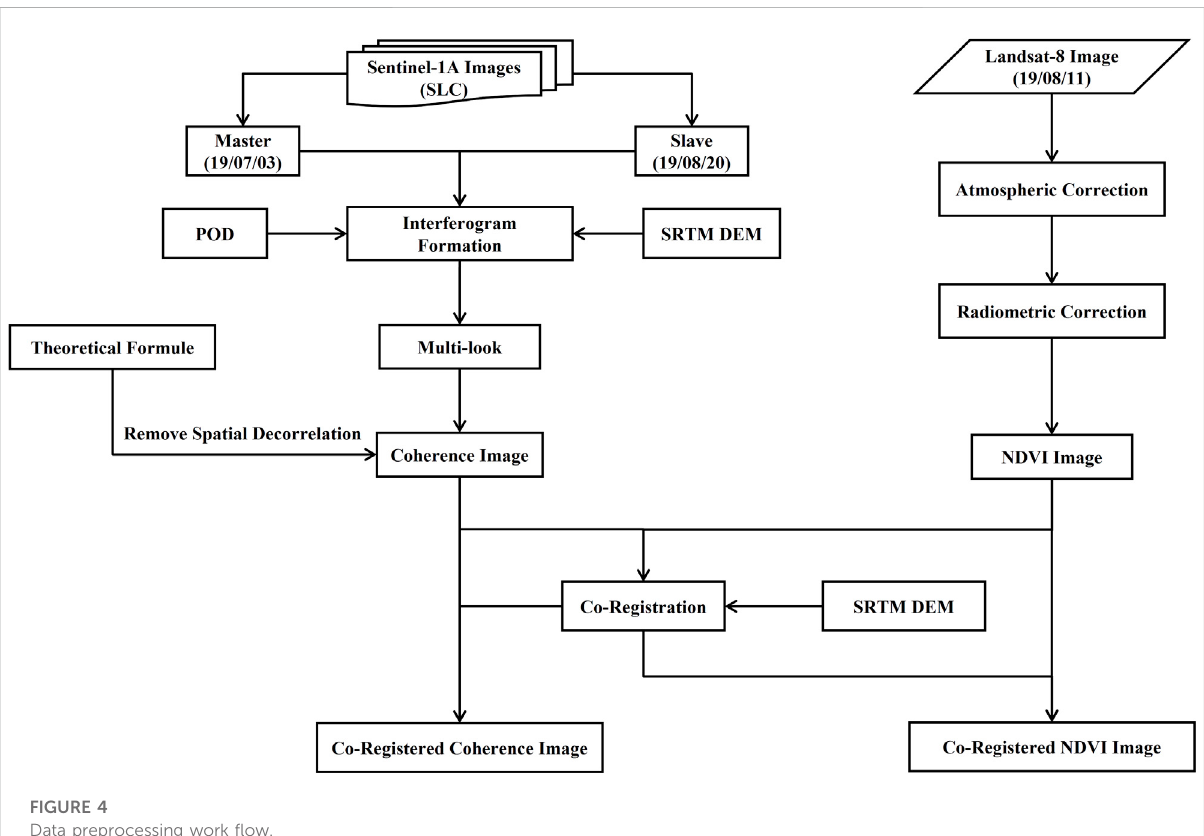
FIGURE 4 Data preprocessing work fl